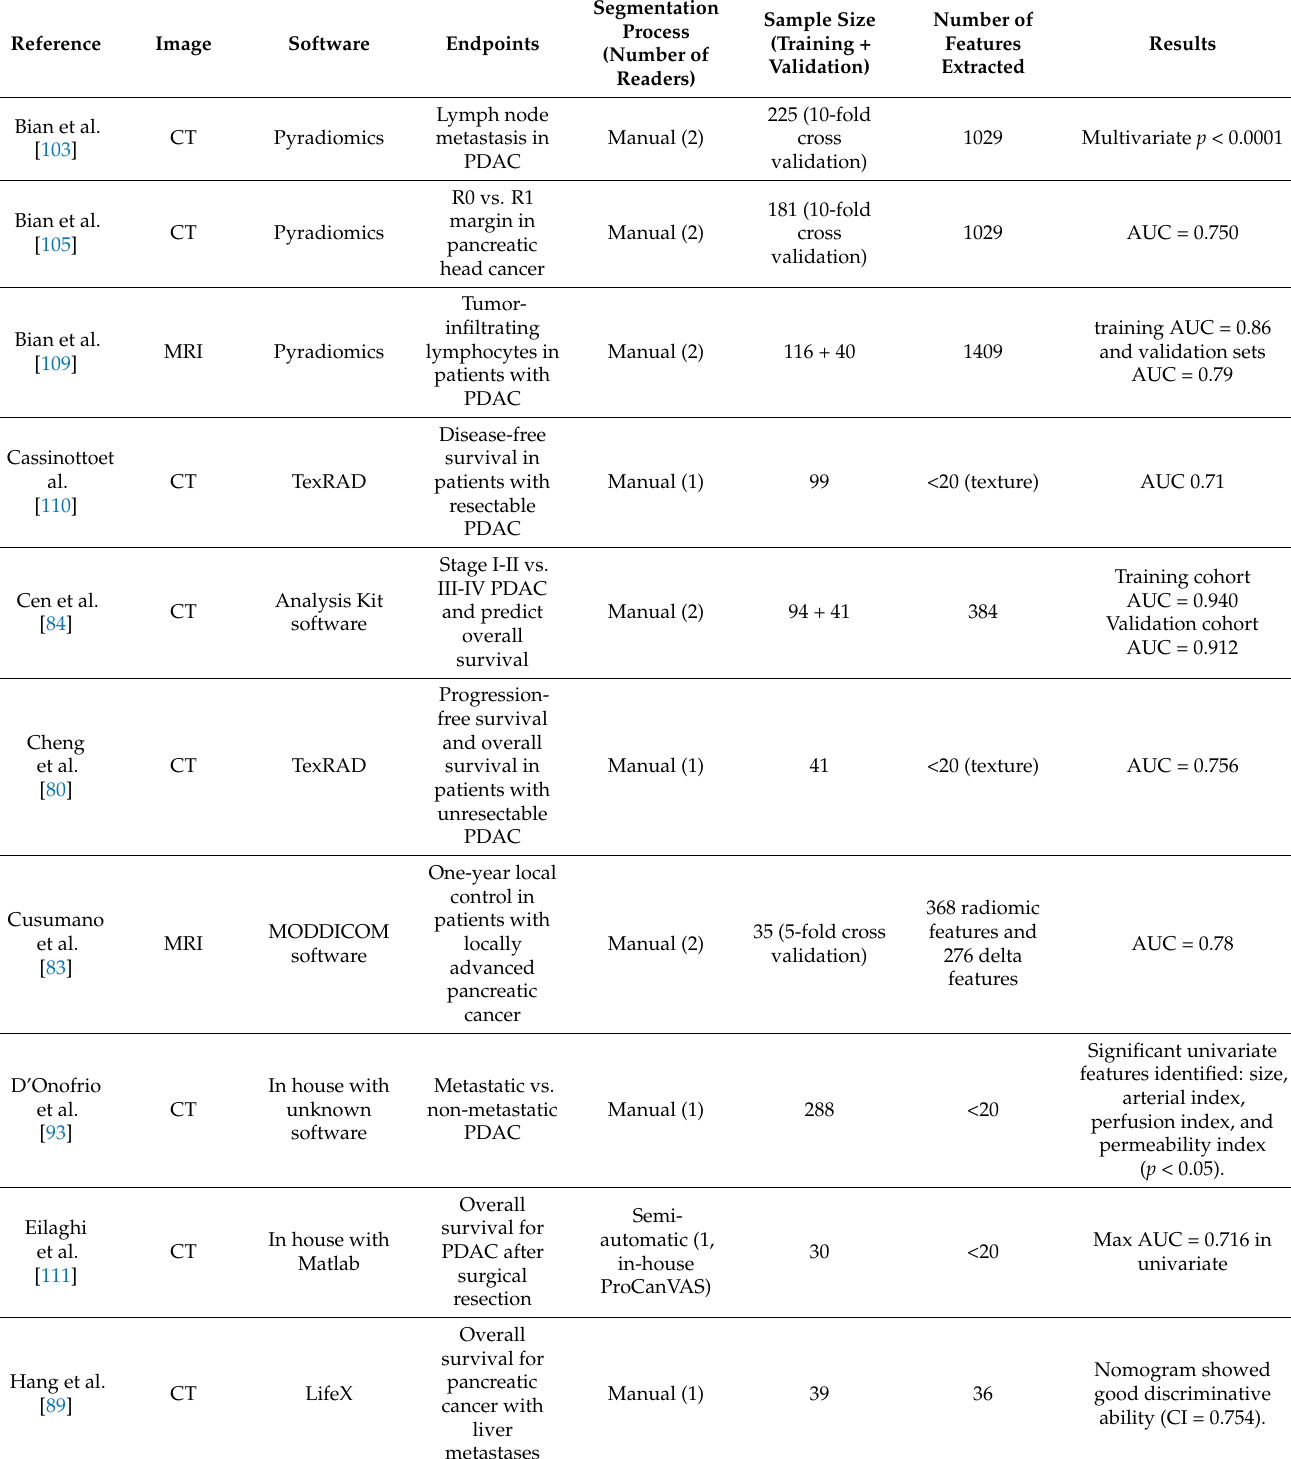
Table 5. Radiomics studies in pancreatic cancer